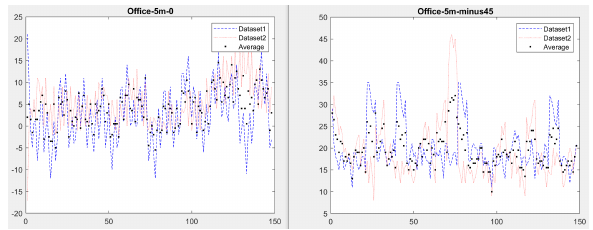
Figure 13 . A further average error plot including more angles at the distance of 5 m.